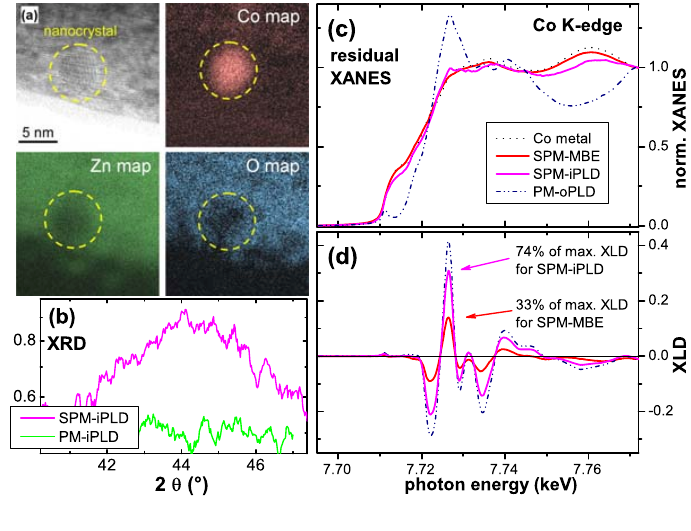
Figure 13. (a) Metallic Co nanoclusters in the SPM-iPLD sample: High-resolution TEM image revealing a nanocrystal with a diameter of about 4 nm. This region is rich in Co, but deficient in Zn and O demonstrated by energy filtered TEM. (b) ! -2 (cid:18) XRD scans revealing an additional reflection for the SPM-iPLD sample which is absent for the PM-iPLD sample. (c) Residual XANES signatures at the Co K -edge of the SPM-MBE and SPM-iPLD samples resembling the reference XANES of Co metal. The residual XANES was derived by subtracting the XANES of the PM-oPLD weighted by the relative reduction of the XLD which is shown in